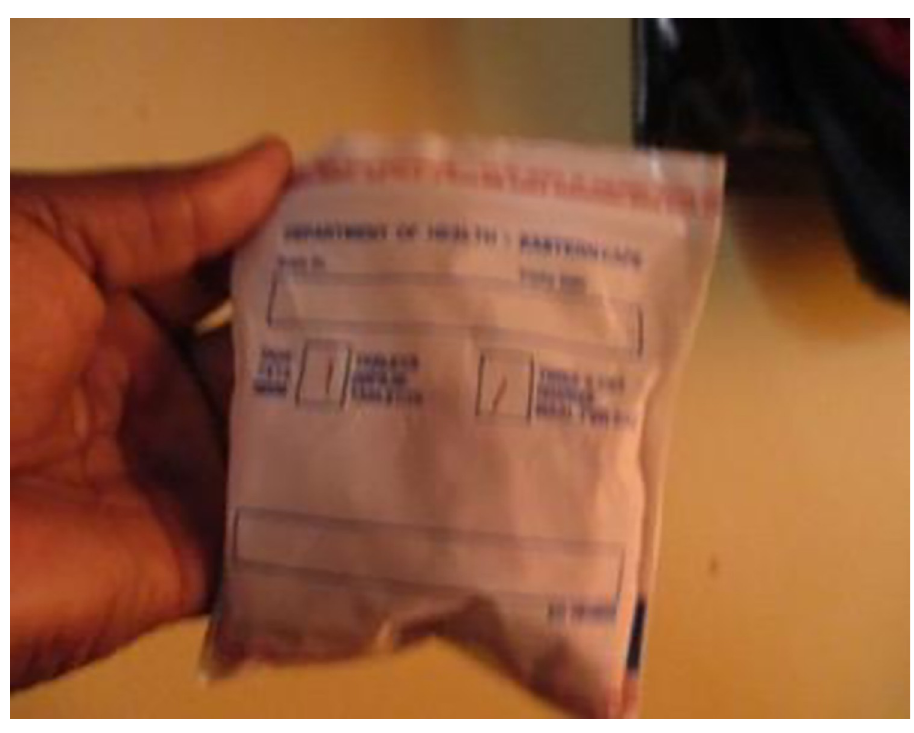
Fig 7. Image from co researcher